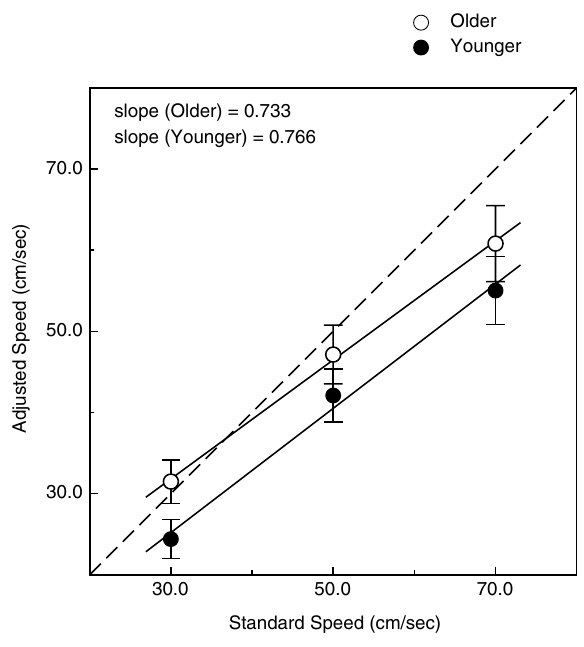
Figure 1. The younger and older participants’ adjusted test speeds as a function of the standard speed. Accurate performance would be indicated by the dashed line. The younger and older participants’ results are indicated by filled and open circles, respectively. The error bars indicate ± 1 SE. The best fitting linear regressions are shown, as well as the slopes of those regressions. One can see that as the standard speed is increased, the perceived speed increases at essentially the same rate for younger and older adults.